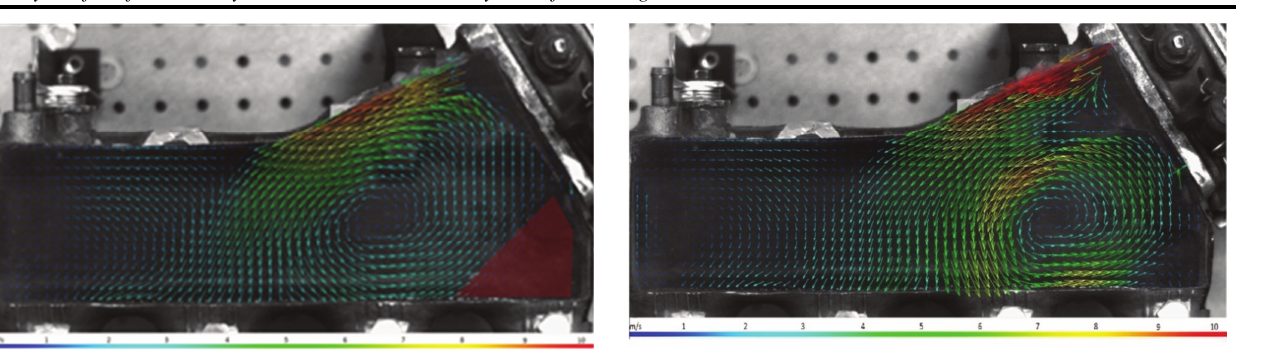
Fig. 10. Velocity vector distribution and air flow direction in the intake manifold at 1500 RPM engine speed and 20˚ throttle position angle